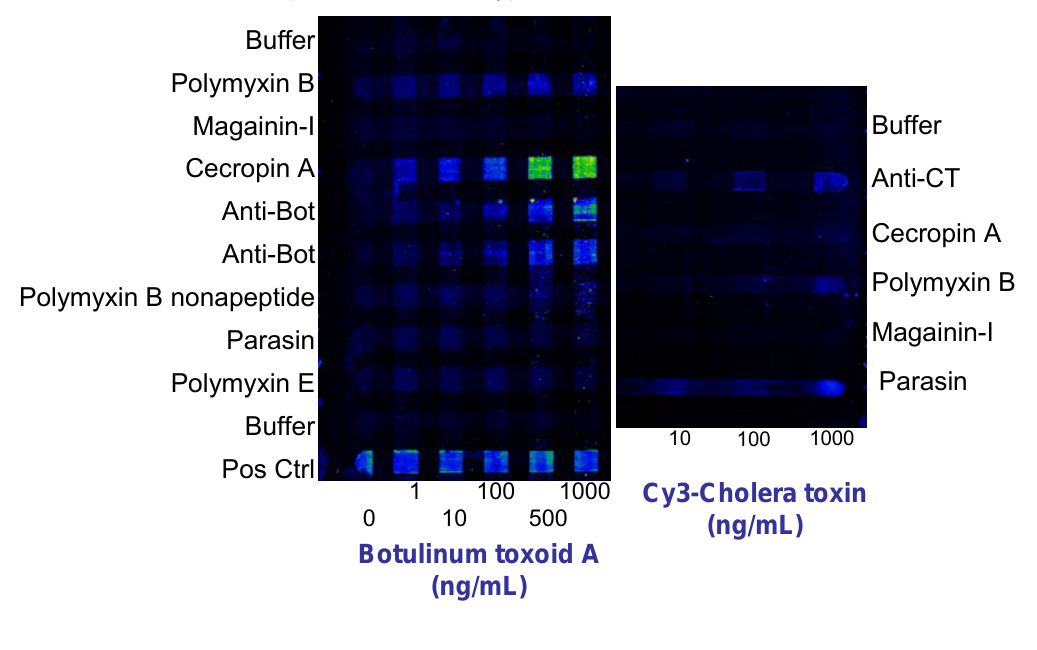
Figure 5 . Detection of botulinum toxoid A and cholera toxin using antimicrobial peptides (AMPs). Immobilized AMPs were used as recognition species for capture of inactivated botulinum toxin A (left) and cholera toxin (right). After incubation of botulinum toxoid A with the arrays, Cy3-labeled tracer antibodies were used to interrogate the array for captured toxin (sandwich format). Cholera toxin assays utilized a direct assay format using Cy3-labeled cholera toxin (no tracer